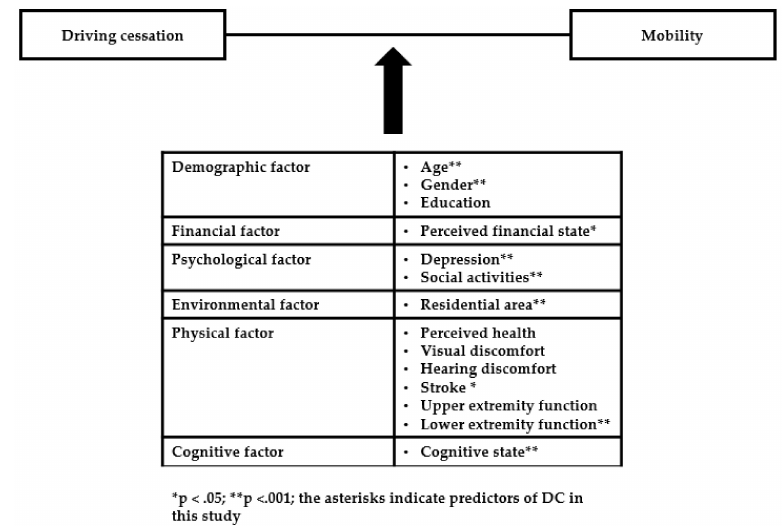
Figure 1. Factors of driving cessation based on a comprehensive mobility framework in this